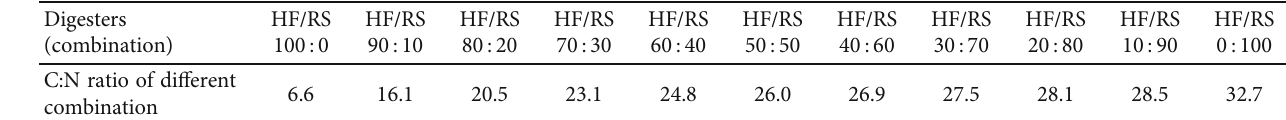
Table 4: C:N ratio for the